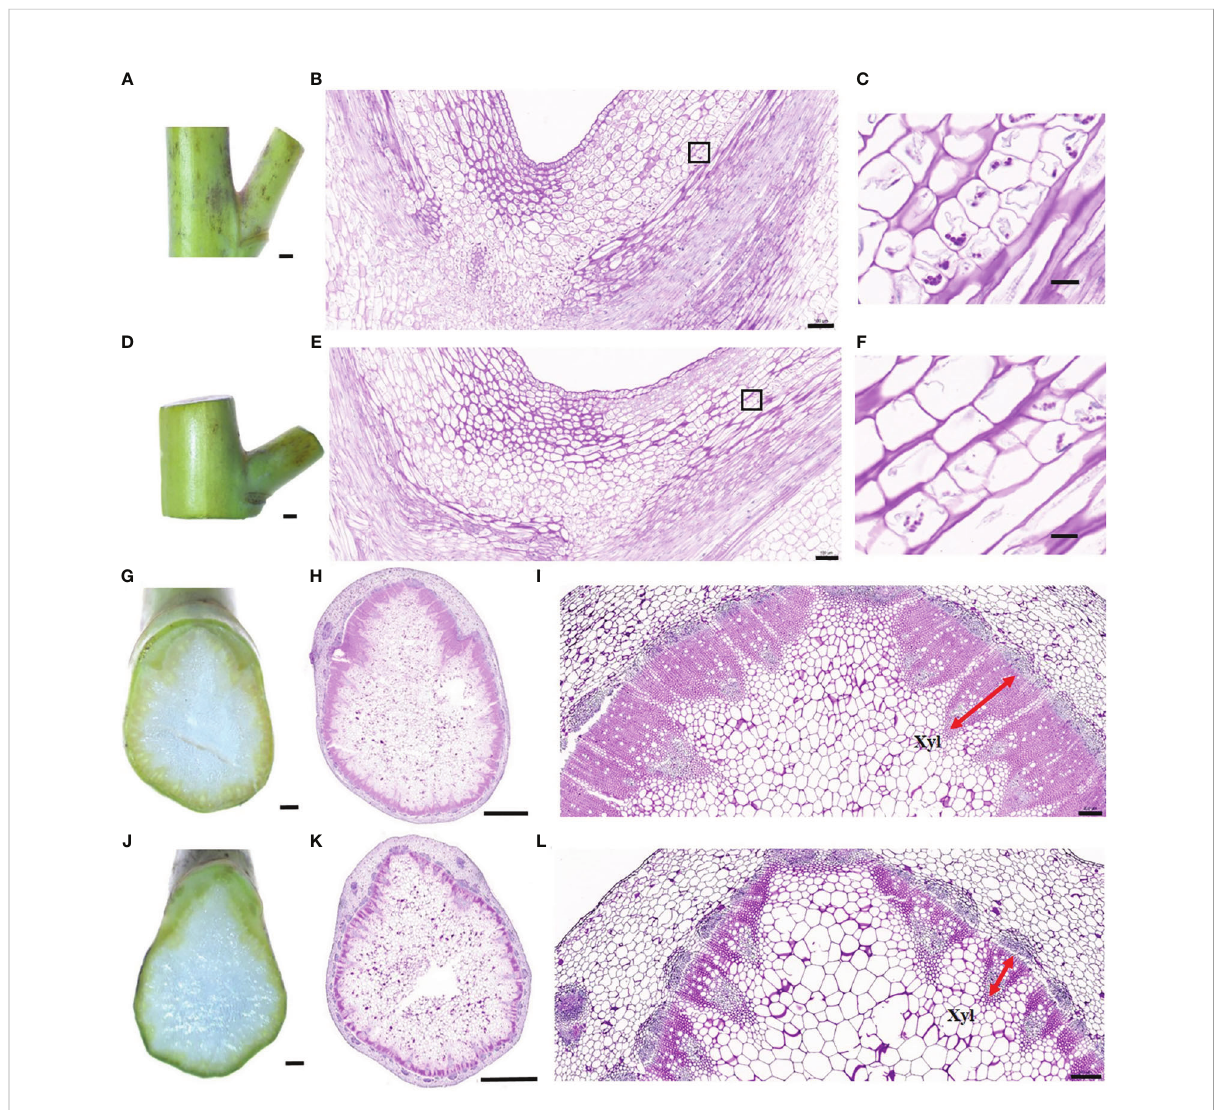
FIGURE 2 Cytological observation of branch joints between compact and loose accessions. (A) Branch joint of the compact accession (8S056). (B) Longitudinal section of branch joint from the compact accession. (C) Enlarged view of a black rectangular box indicated region of (B) . (D) Branch joint of the loose accession (8S092). (E) Longitudinal section of branch joint from the loose accession. (F) Enlarged view of the black rectangular box indicated region of (E) . (G – I ) The bottom horizontal section of the branch joint in the compact accession (8S056). (J – L) The bottom horizontal section of the branch joint in the loose accession (8S092). The red arrow indicates the xylem. Bars = 1 mm in (A, D, G, J) , 2 mm in (H, K) , 500 m m in (B, E, I, L) , and 20 m m in (C, F)